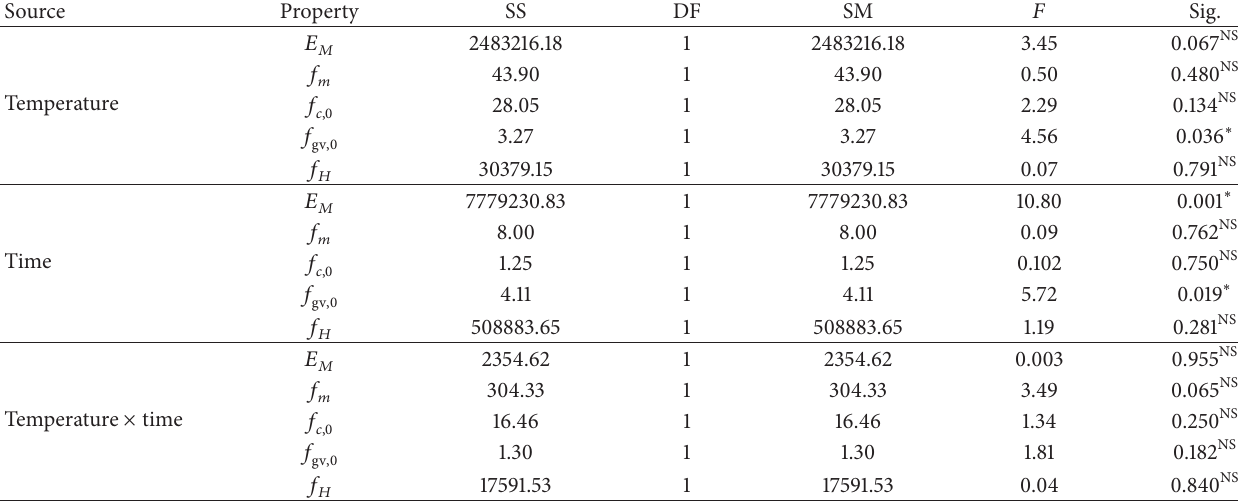
Table 5: Factor analysis of the plywood’s mechanical